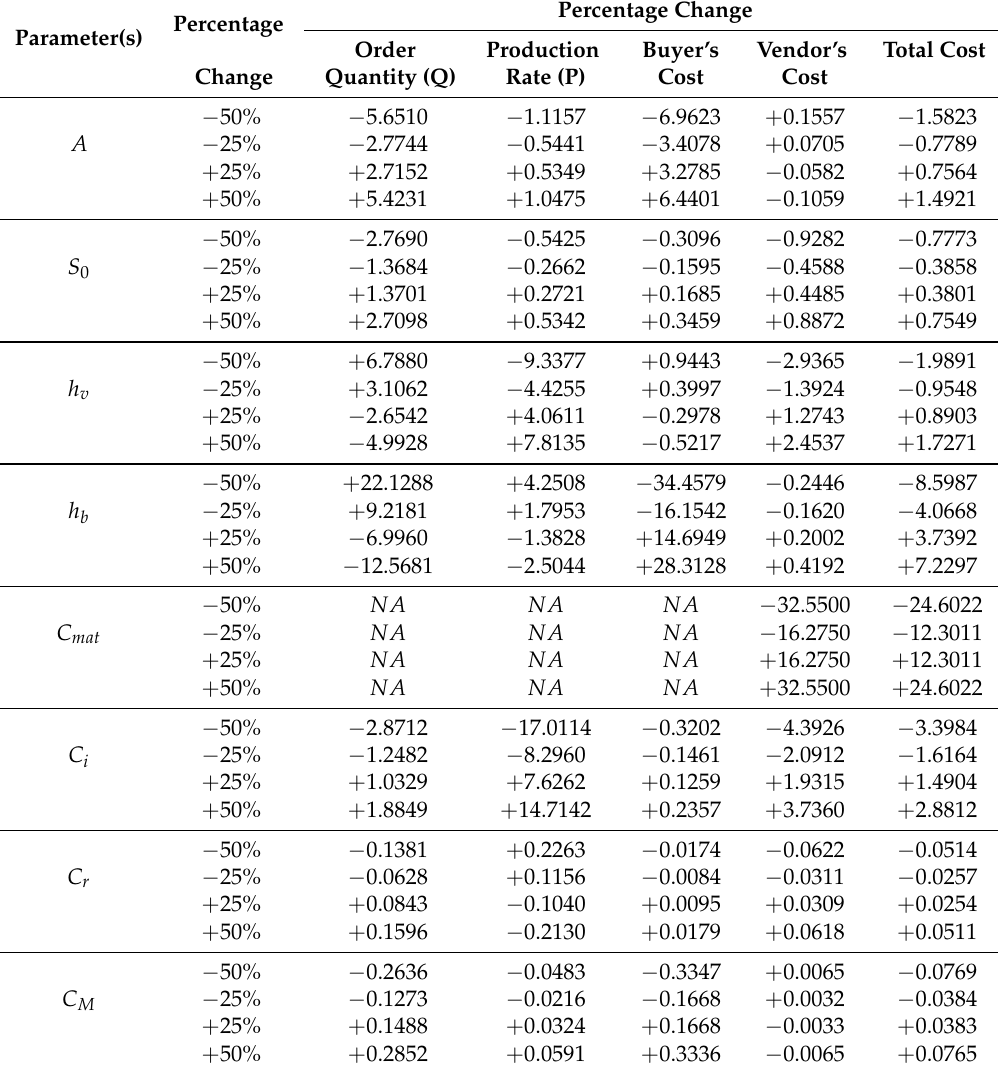
Table 7. Sensitivity analysis for centralized